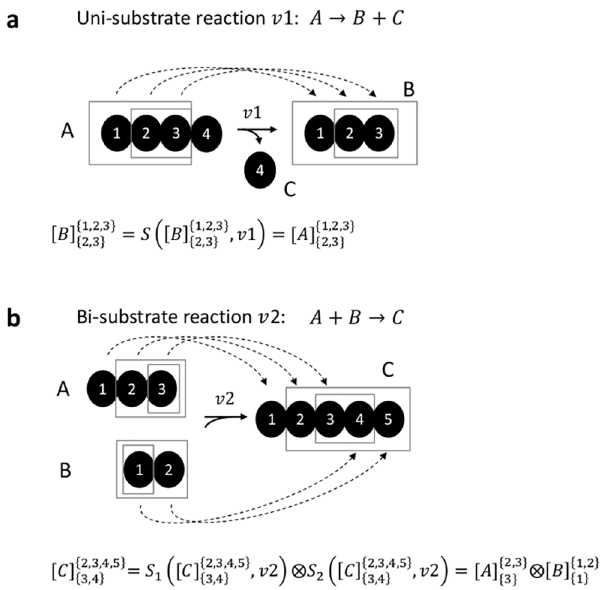
Fig 2. Calculating the tandemer distribution matrix of a product MFP based on tandemer distribution matrices of substrate MFPs in uni-substrate (a) and bi-substrate (b) reactions.